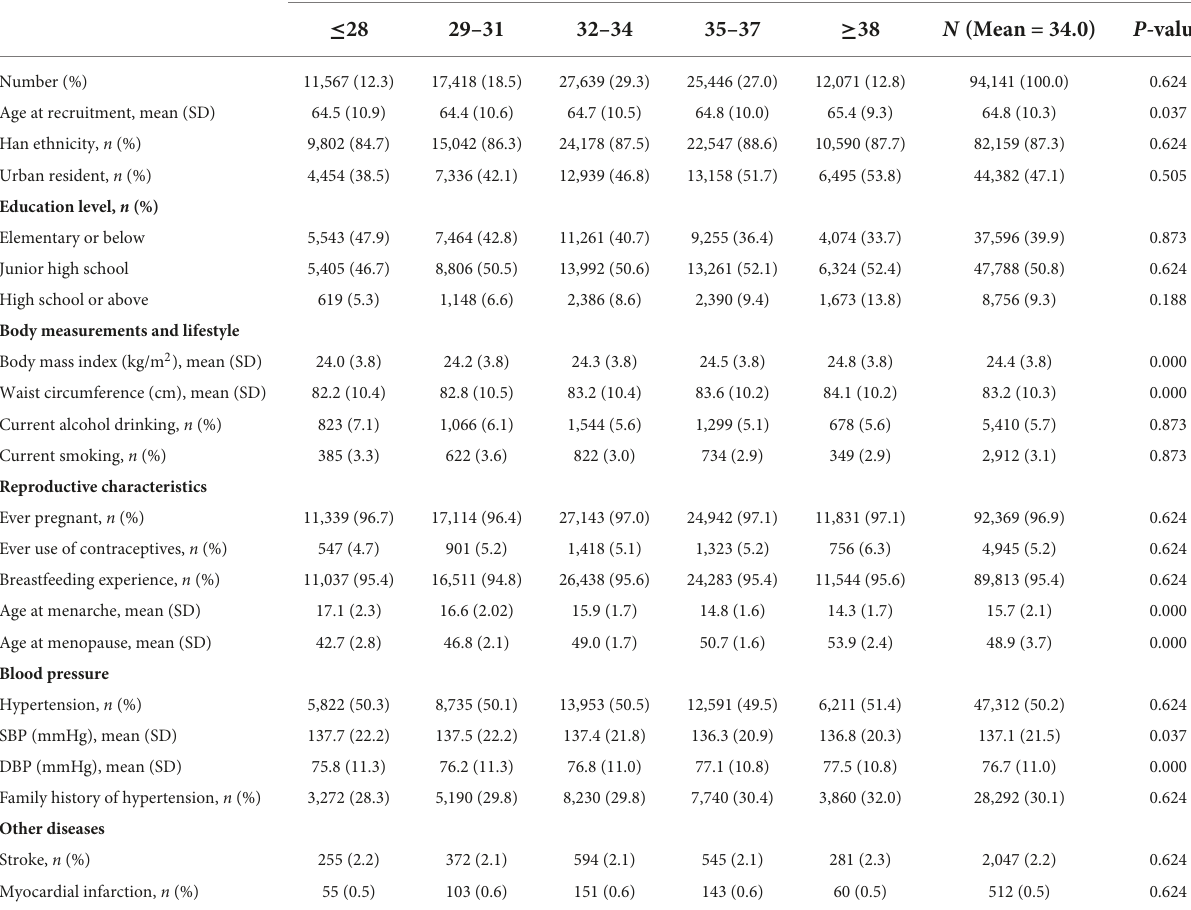
TABLE 1 Characteristics of study participants by reproductive lifespan.